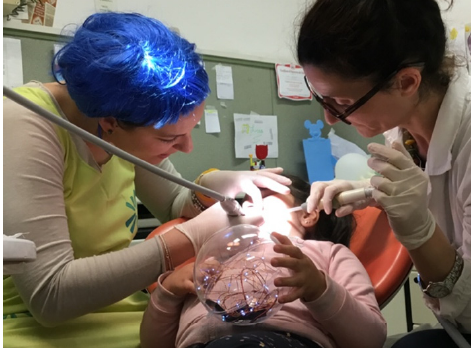
Figure 3. Dental room and the involved staff.